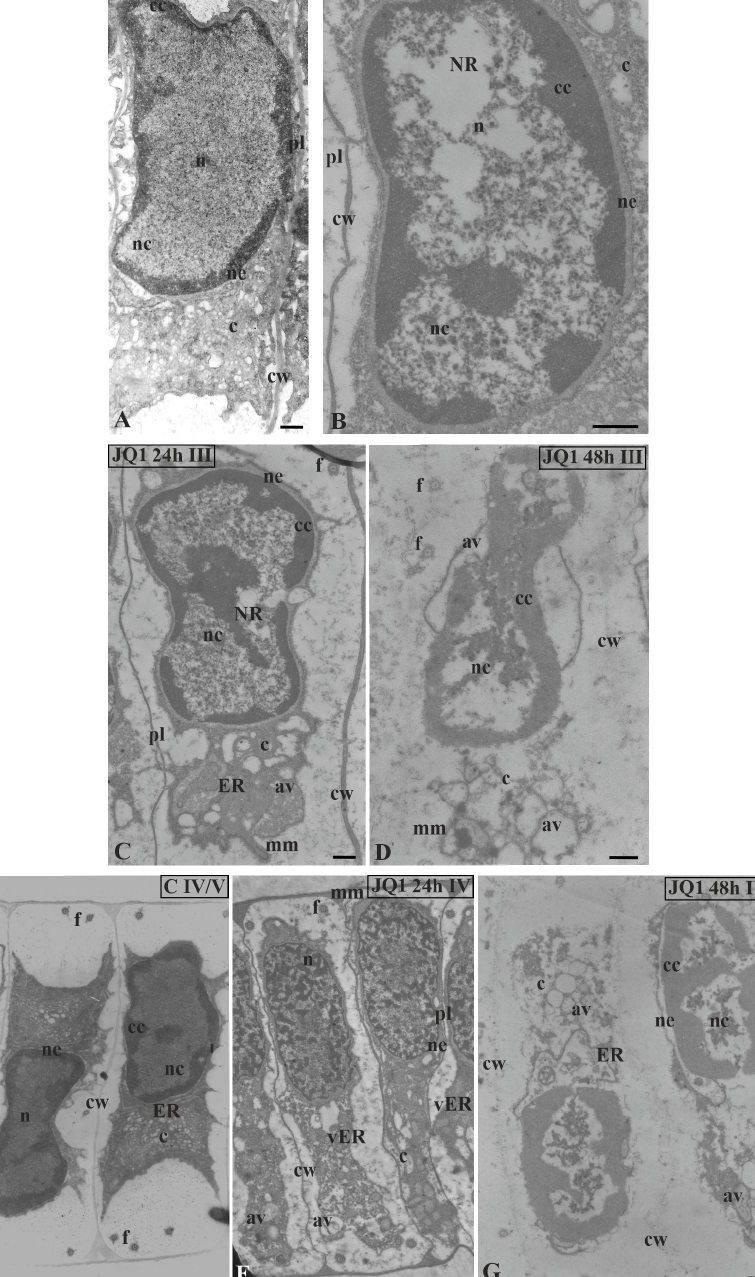
Figure 5. The e ff ect of JQ1 on C. vulgaris spermatids ultrastructure at stage III ( A – D ) and IV ( E – G ); ( A , E ) the control; ( B – F ) after 24 h ( B , C , F ) and 48-h ( D , G ) treatment with JQ1; extended nuclear envelop ( B , C ) and bright spaces in nucleus in non-condensed chromatin ( B – D , G ), these spaces cover almost the whole central part of the nucleus ( D ); ( C ) reduced cytoplasm with dilated ER cisternae; ( D , G ) barely visible cell wall between spermatids, strongly reduced cytoplasm, ER cisternae not visible, and a lot of vesicles and lytic vacuoles are present; ( E – G ) nuclei shifted to one of the side walls, net-like chromatin pattern ( F ) is not typical of this stage. Longitudinal section of spermatids; av, autolytic vacuole; c, cytoplasm; cc, condensed chromatin; cw, cell wall; ER, endoplasmic reticulum; f, flagellum; mm, microtubular manchette; n, nucleus; nc, non-condensed chromatin; ne, nuclear envelope; NR, nuclear reticulum; pl, plasmodesmata; vER, endoplasmic reticulum vesicle; on individual images in the frame treatment, time of treatment, and stage of spermiogenesis were given; Scale bar = 500